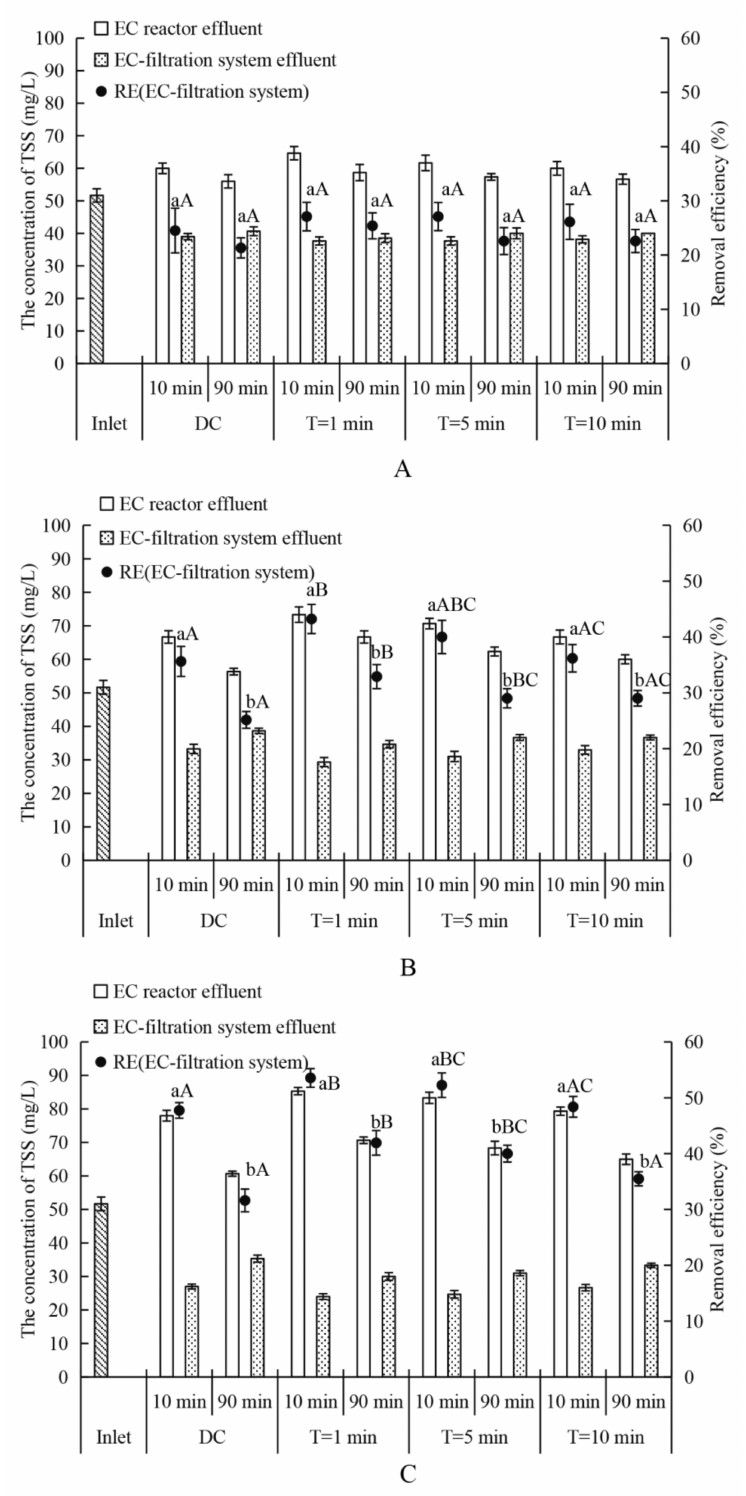
Figure 4. Effects of current density and CCP on the removal of TSS by the EC − filtration system (( A ) j = 15 A/m 2 , ( B ) j = 30 A/m 2 , ( C ) j = 45 A/m 2 ). In the same CCP, different lowercase letters on the RE(EC − filtration system) indicate significant differences ( p < 0.05). At the same operation time across different CCPs, different uppercase letters on the RE(EC − filtration system) indicate significant differences ( p <